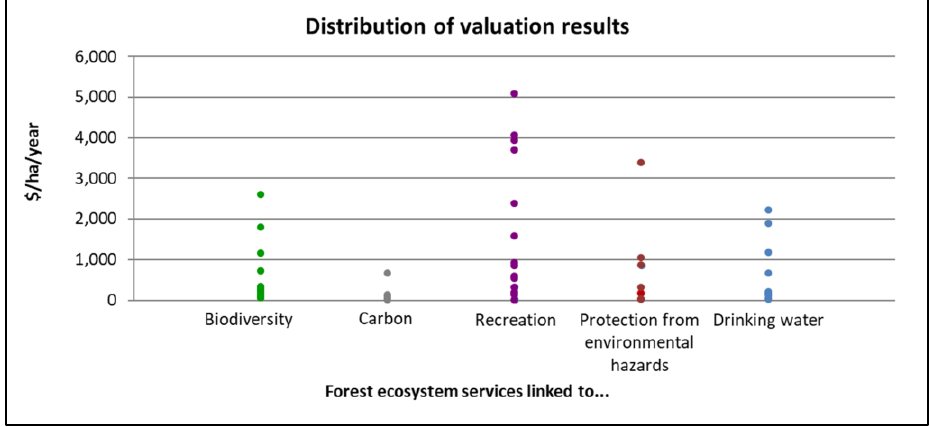
Figure 5. Distribution of economic valuation results extracted from the developed database. (Existing values above 6000 $/ha/year are omitted in the figure for presentation purposes).